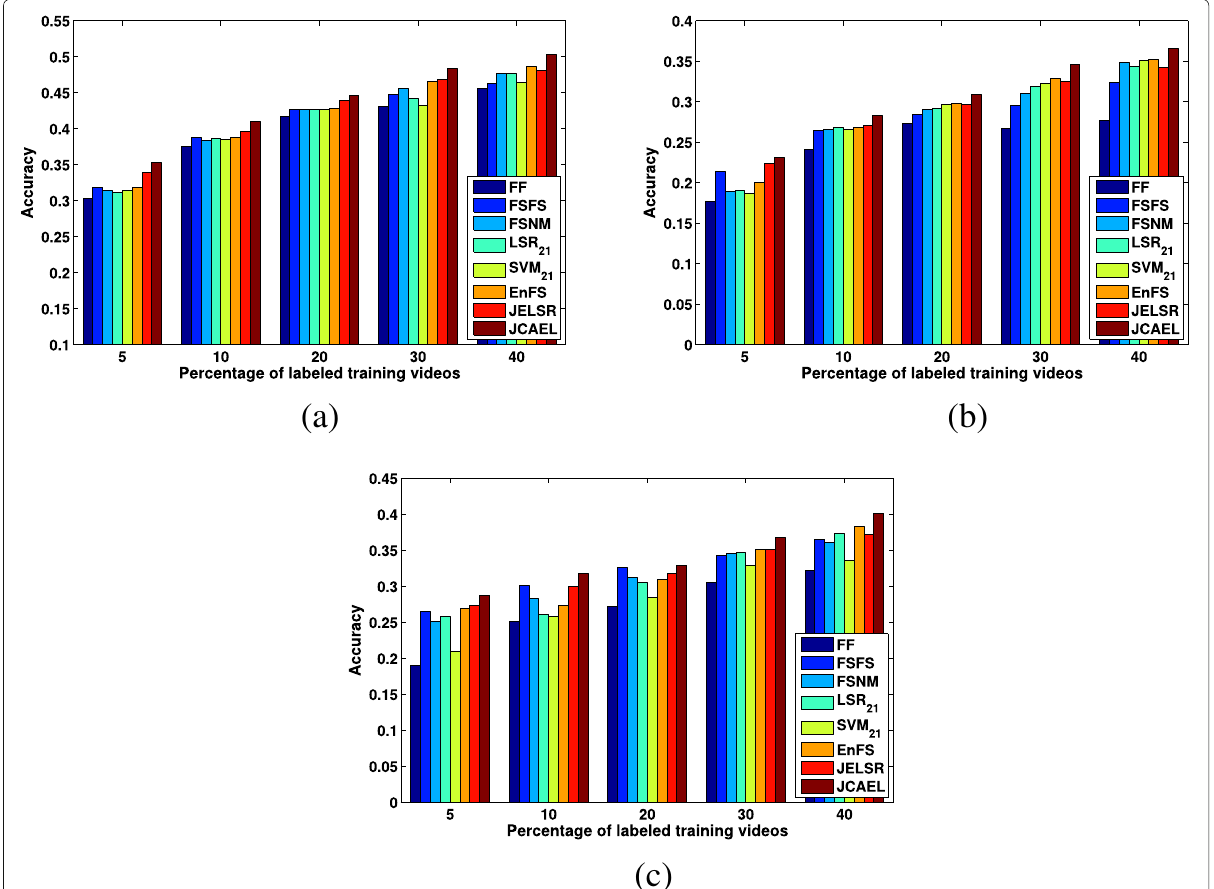
Fig. 1 Classification results of different methods on HMDB13 ← EID when the ratios of labeled video data are different. a LMCSVM as classifier. b LSR as classifier. c MCkNN as